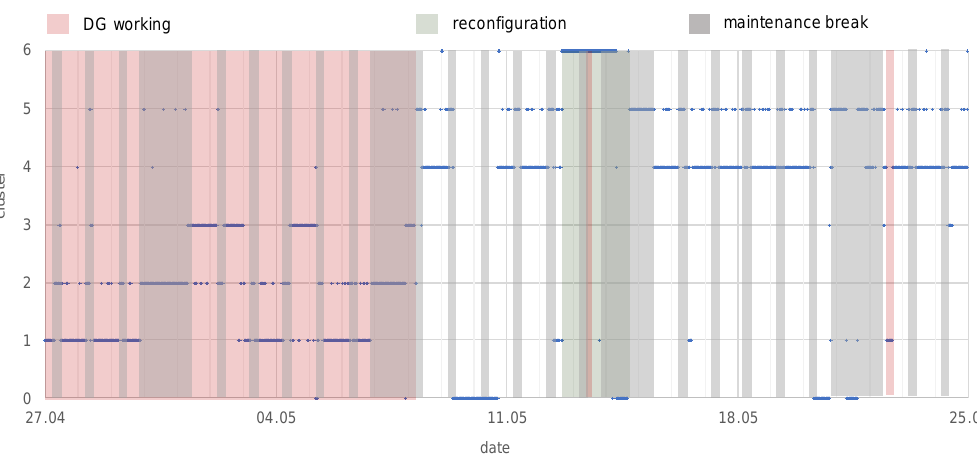
Figure 9. Cluster analysis results for the final number of clusters equal to